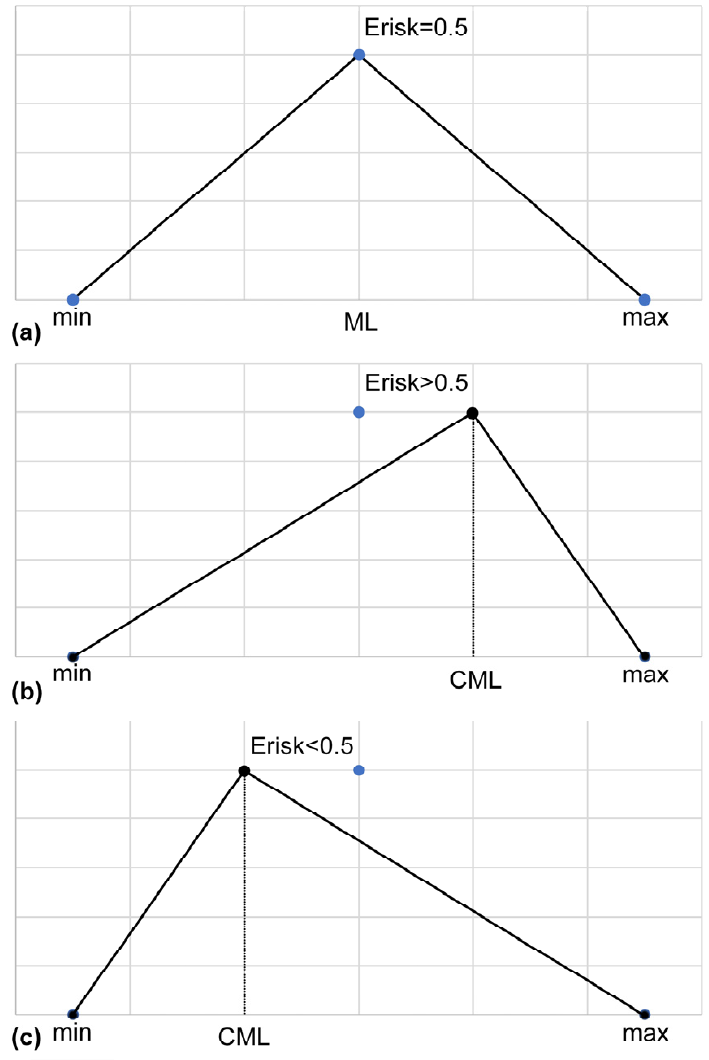
Figure 5. Estimation of task execution time. ( a ) Traditional PERT estimation, ( b ) proposed estimation based on effective risk model, Erisk > 0.5, ( c ) proposed estimation based on effective risk model, Erisk < 0.5.